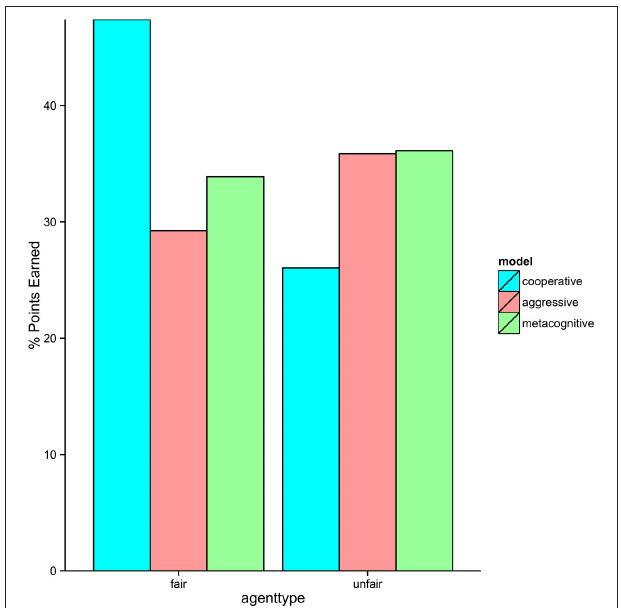
FIGURE 7 | Performance of each version of the model against the two non-cognitive agents.